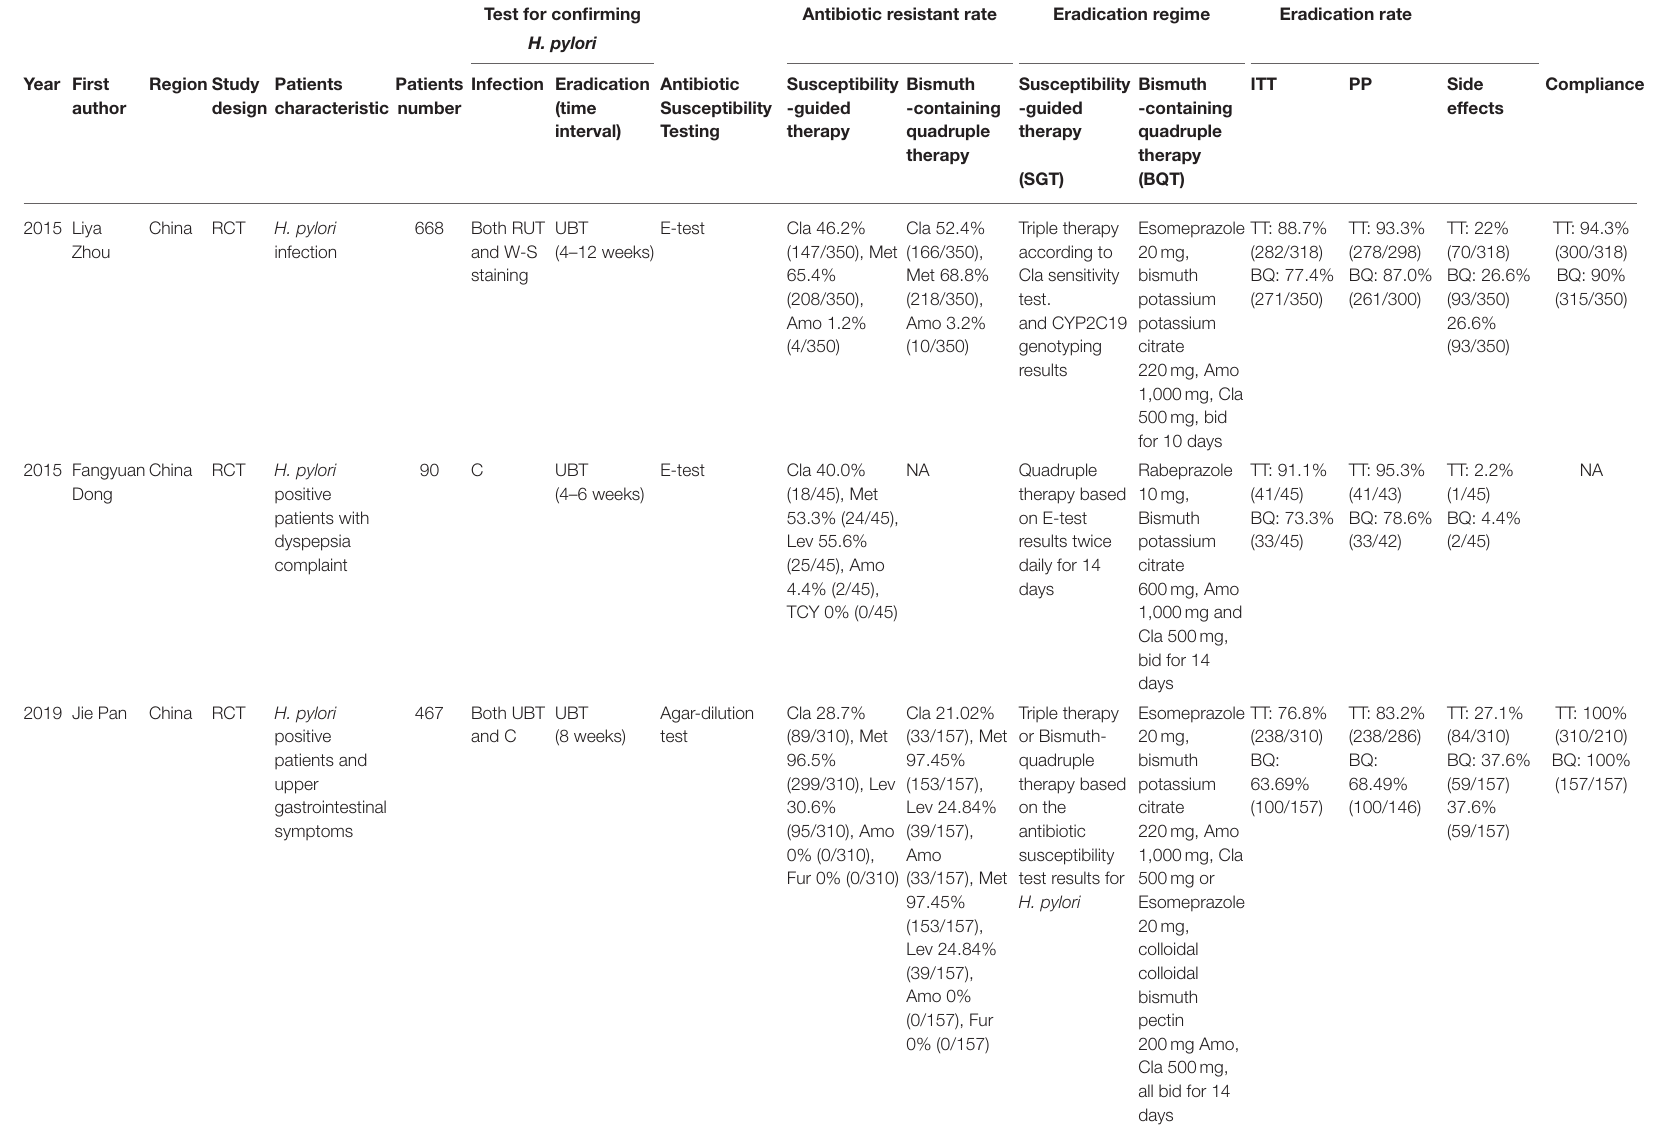
TABLE 1 | Characteristics of the studies included in the